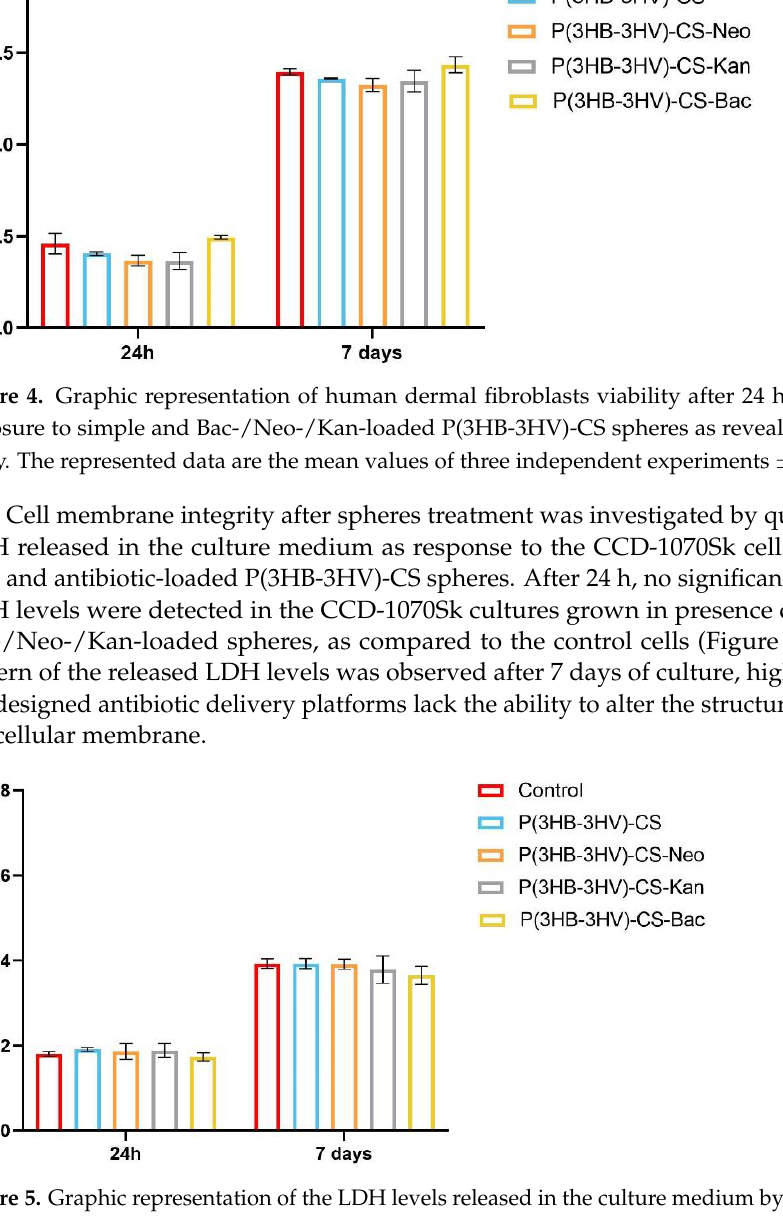
Figure 5. Graphic representation of the LDH levels released in the culture medium by human der- mal fibroblasts after 24 h and 7 days of treatment with simple and Bac-/Neo-/Kan-loaded P(3HB- 3HV)-CS spheres. The represented data are the mean values of three independent experiments ± S.D.